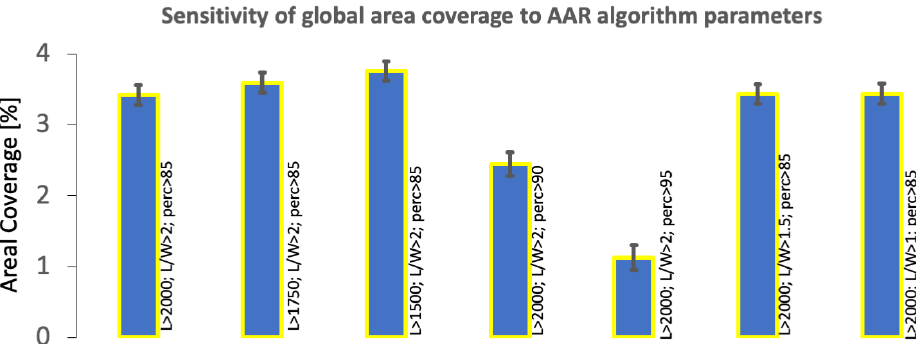
Figure 10. AAR and AR sensitivity of the global area coverage to threshold values used for three key parameters in the detection algorithm. For each species of AARs, the first bar shows the average global area coverage for the length limit > 2000, aspect ratio > 2, and the pixel- wise IAT threshold > 85%. The next two bars show the areal coverage after relaxing the length limit to 1750 and 1500km. The fourth and the fifth bars show the areal coverage after increasing the pixel-wise IAT limit to 90th and 95th percentile. The last two bars show the areal coverage after relaxing the aspect ratio to 1.5 and 1. Standard deviations show the variations in areal coverage by different